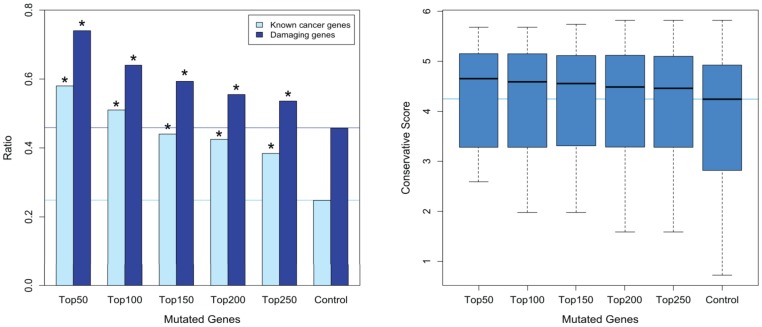
The difference in A, the percentage of known cancer genes or damaging genes and B, the conservative score between five groups of mutated genes and control genes.Five groups of mutated genes were ranked in the top 50, 100, 150, 200 and 250 by betweenness coefficient of the network. Control genes are mutated genes with a betweenness coefficient of zero. The horizontal line parallel to the x axis represents the longitudinal coordinates of the control genes. * represents a significant difference (p<0.05).